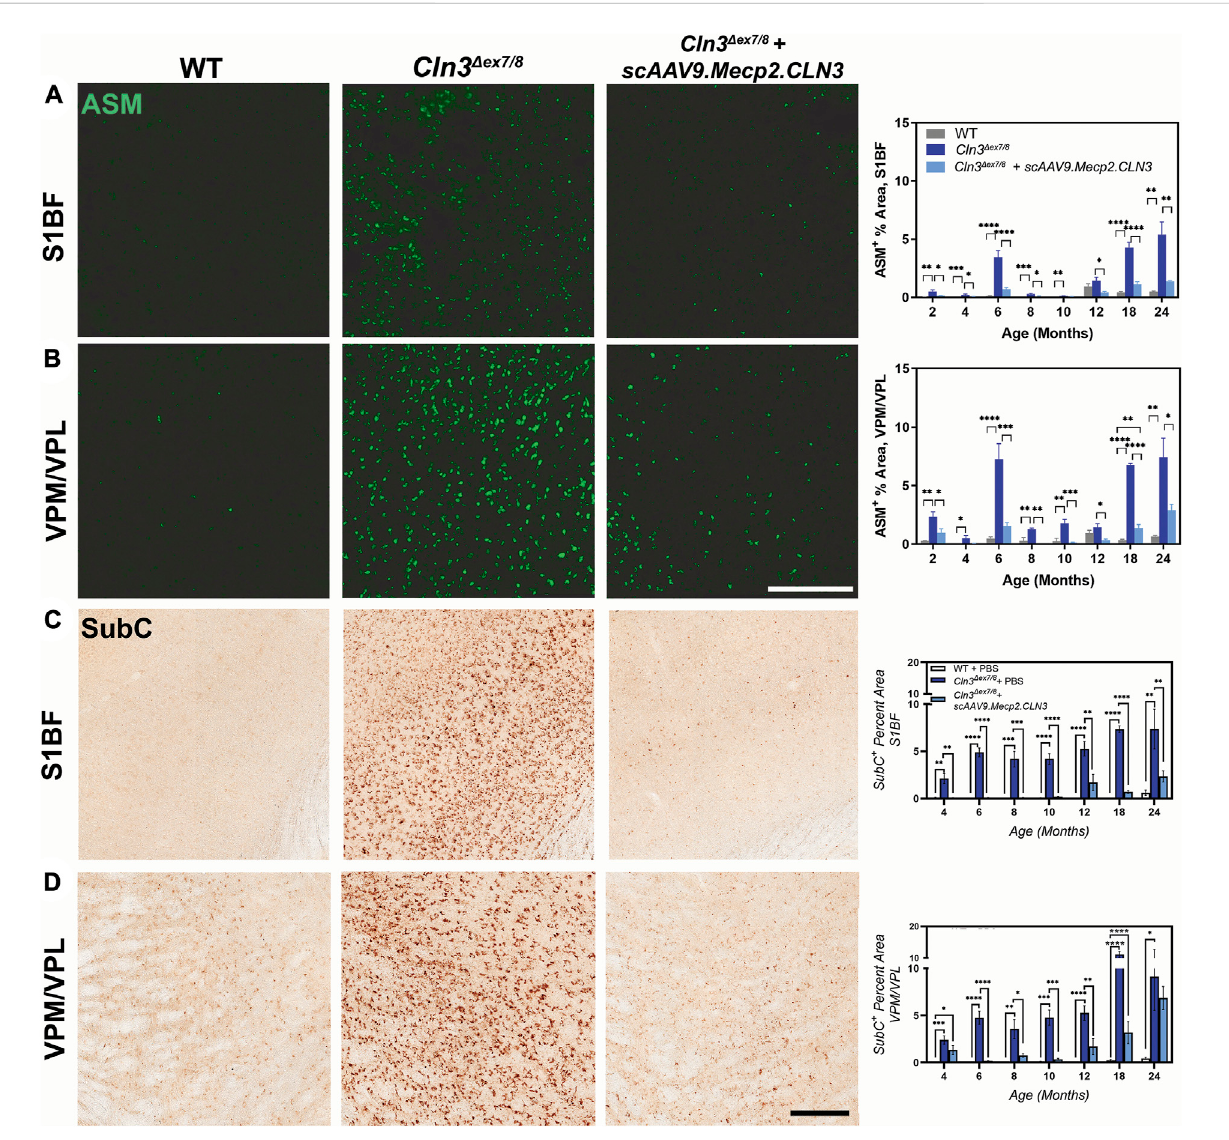
FIGURE 3 scAAV9.Mecp2.CLN3 administration attenuates storage material accumulation in Cln3 Δ ex7/8 mice. AAV9 administration attenuates auto fl uorescent storage material accumulation in the S1BF (A) and VPM/VPL (B) from 2 to 24 months of age in Cln3 Δ ex7/8 mice. Similarly, AAV9 administration attenuates the accumulation of a lipofuscin constituent, mitochondrial ATP synthase subunit c (SubC) in the S1BF (C) and VPM/VPL (D) throughout the lifespan of Cln3 Δ ex7/8 mice. One-way ANOVA, Tukey correction at each time point, as each time point was processed independently. Mean ± SEM. * p < 0.05, ** p < 0.01, *** p < 0.001, **** p < 0.0001. Scale Bars = 200 µm, images presented are from 6 months of age. 8 images/region/animal were examined for ASM; 12 images/region/animal were examined for